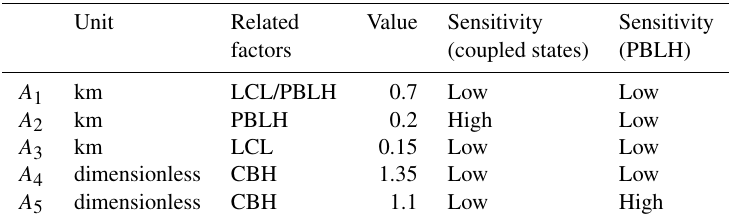
Table 1. List of parameters in the flowchart of DTDS (Fig. 4).